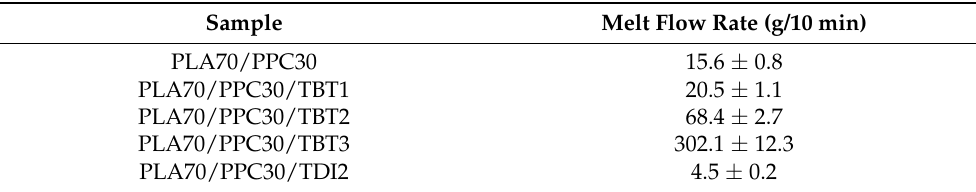
Table 2. Melt index values of PLA70/PPC30 blends with TBT or